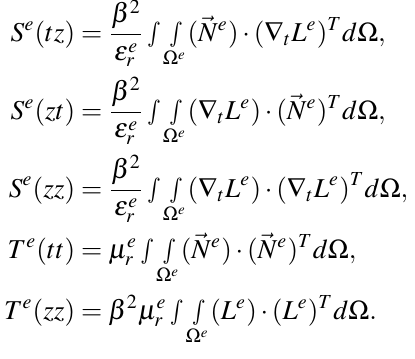
Fig. 1 Cross-sections of undeformed and deformed samples of three kinds of finlines. (A) Unilateral finline, (B) Deformed unilateral finline, (C) Antipodal finline, (D) Deformed antipodal finline, (E) Bilateral finline and (F) Deformed bilateral